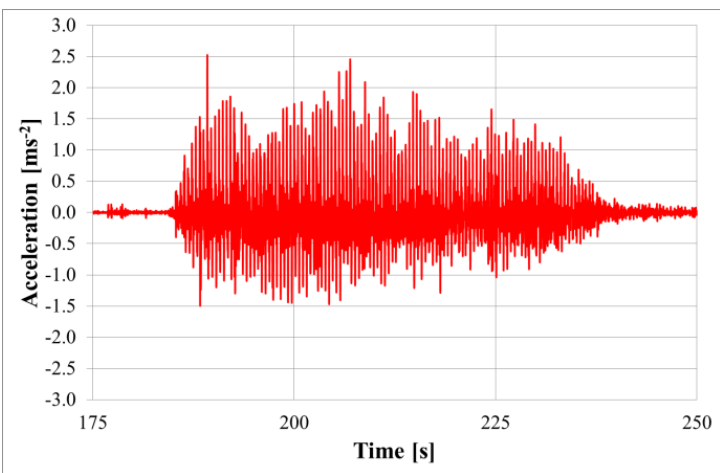
Types of Jumping Jumping of the 2 nd Jumping of the 3 rd